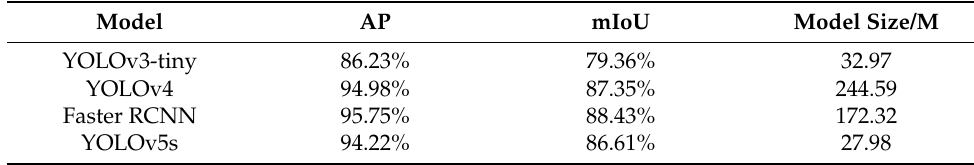
Table 1. Comparison results of object